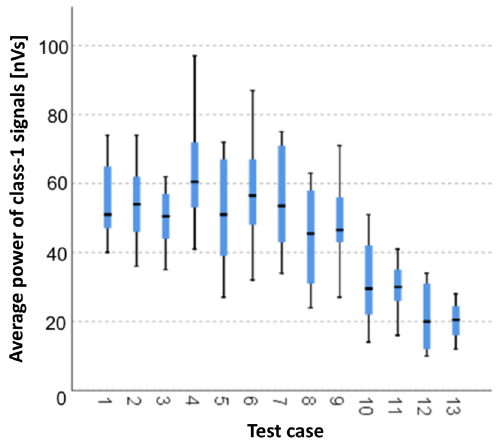
Figure 3. Graphic presentation of the Kruskal–Wallis test results for independent samples: average strength of class-1 signals.